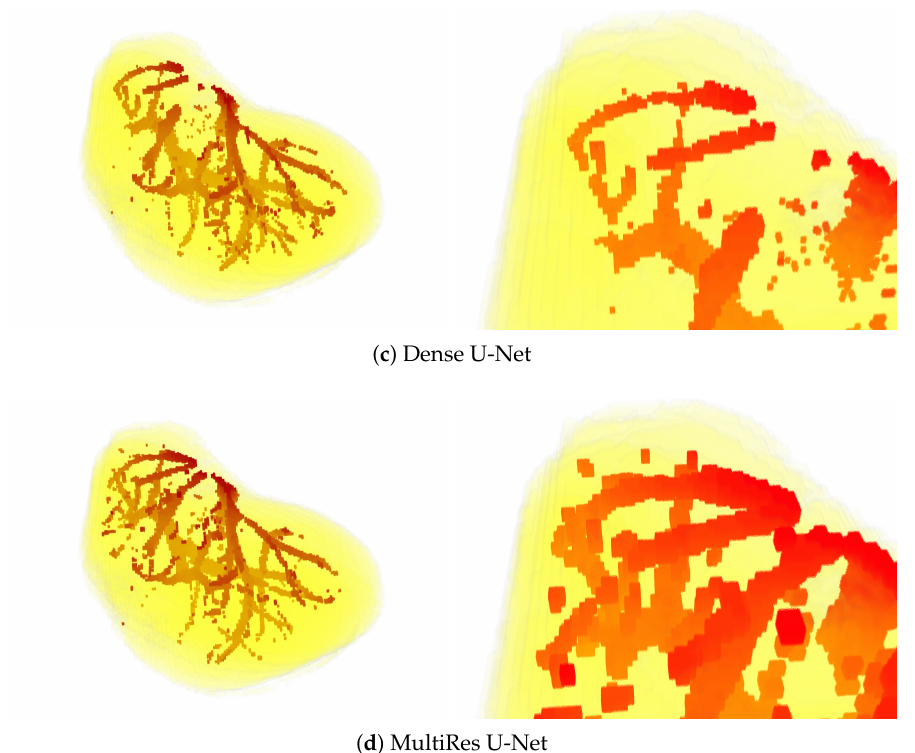
Figure 5. 3D views of segmentations obtained from the first patient of IRCAD dataset, with the full 3D volume approach. The upper part of the visualization is also zoomed in